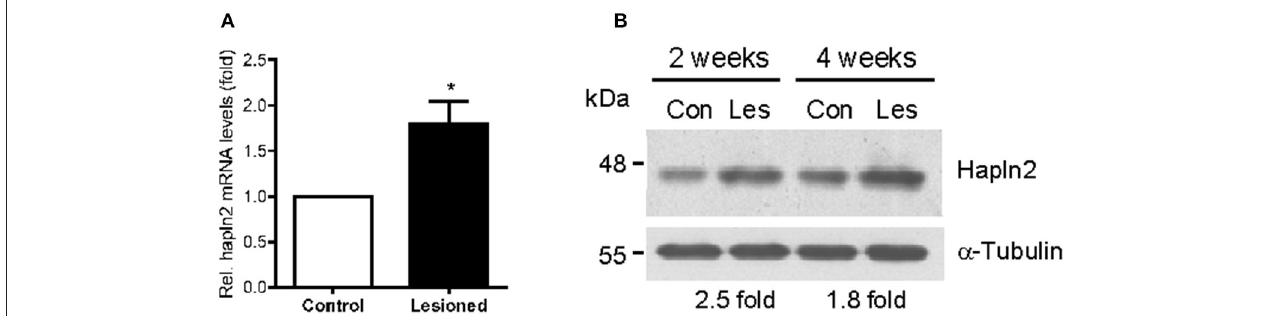
FIGURE 3 | Expression of Hapln2 is up-regulated in the substantia nigra of rat PD model. (A) qPCR reveals the changes of Hapln2 mRNA levels in the SN of rat 2 weeks following 6-OHDA treatment. Data are expressed as mean ± S.E.M. ( n = 3). * P < 0.05. (B) Representative western blots showing Hapln2 expression in the substantia nigra of rat 2 and 4 weeks after 6-OHDA